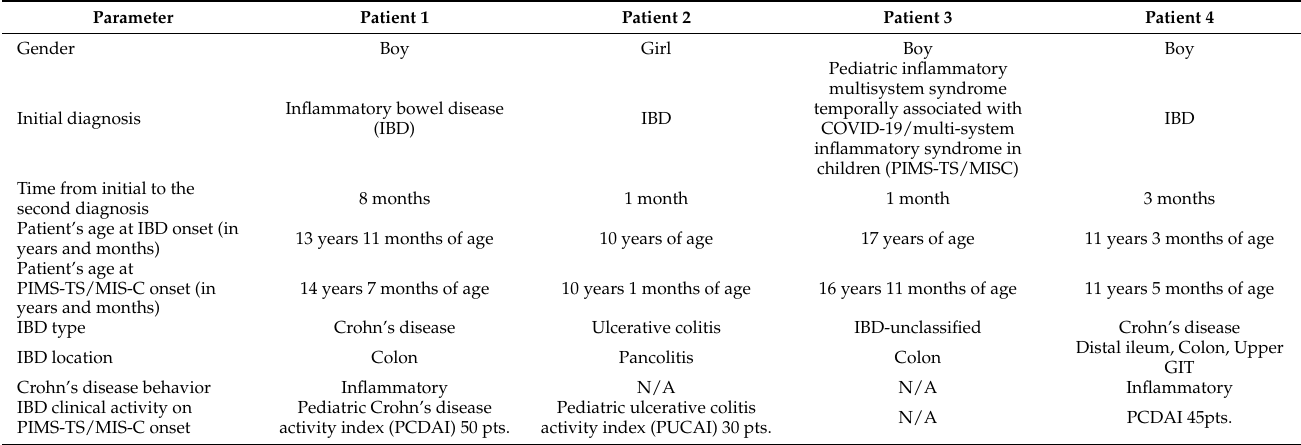
Table 1. Basic characteristics of patients with co-occurrence of IBD and